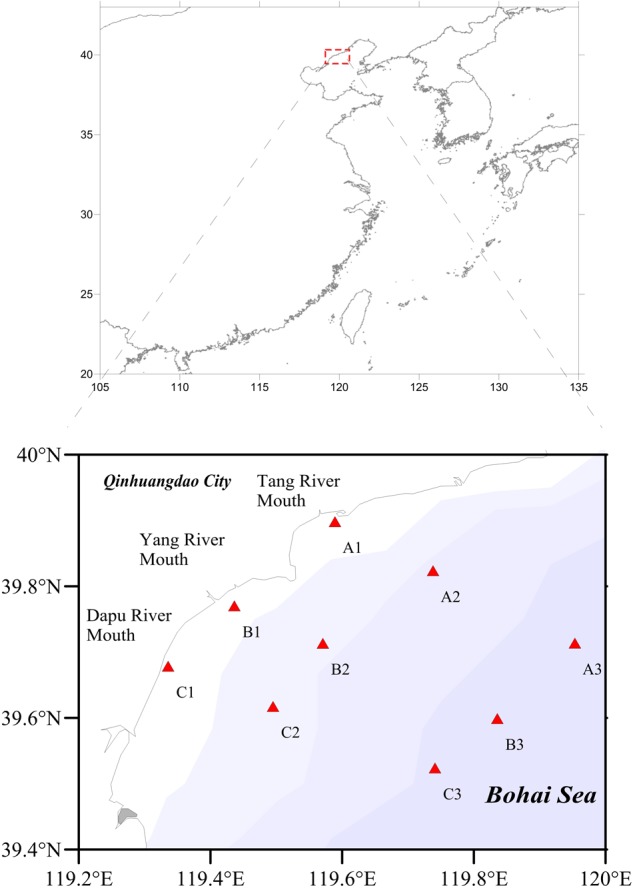
Map of sampling sites in Qinhuangdao coastal area.